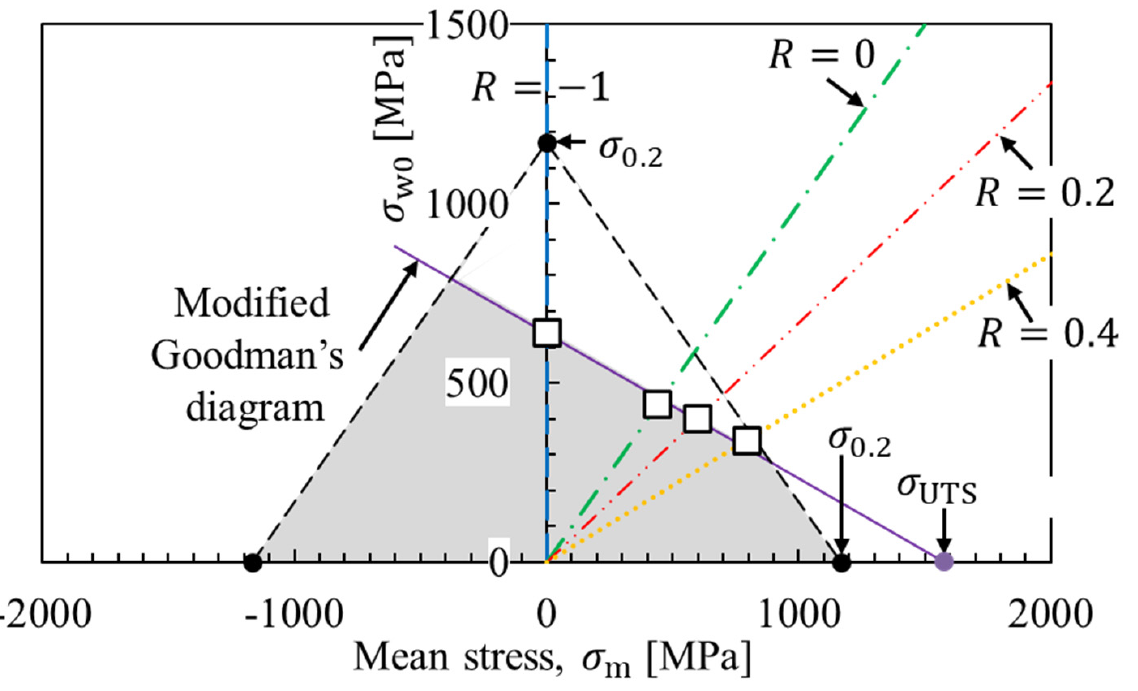
Figure 6. Fatigue limit diagram for smooth specimens. Fatigue tests on the 400 µ m slit specimen, which simulated large defects, were also conducted to determine the ∆ K ( L ) at each stress ratio. The values of ∆ K ( L ) were th th calculated using the fatigue limits of the 400- µ m-slit specimen and Equation (6). Figure 7 shows the relationship between the stress ratio and ∆ K ( L ) . It can be seen that there is th